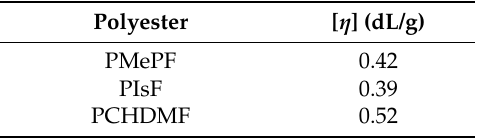
Table 1. Intrinsic viscosity values of the polyesters.